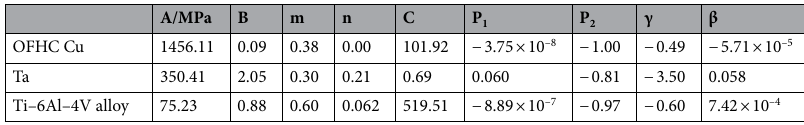
And for Ti–6Al–4V alloy, the strain rate is from 10 –5 to 2700 s −1 , and the temperature is from 233 to 598 K 13,37 . The calculated parameters were displayed in the Table 1. The reference strain rate ˙ ε r is 1 s −1 , and the reference temperature T r is 298 K. The calculation and experiment results are displayed in the Figs. 2, 3 and 4. The results display that the yield stress and work-hardening behavior exhibit a high sensitivity to strain rate and temperature for Cu, Ta and Ti–6Al–4V alloy. It is found that the yield stress decreases with temperature rising but increases with strain rate rising. At the same time, the work-hardening decreases with the increasing of temperature and strain rate. For the example of Ta, at the strain rate of 0.0053 s −1 , the yield stress decreases from 135 to 105 MPa when the temperature increases from 422 to 589 K; at 298 K, the yield stress increases from 110 to 280 MPa when the strain rate increases from 10 –6 to 10 –1 s −1 . Then, for Ti–6Al–4V alloy, the working-hardening decreases when